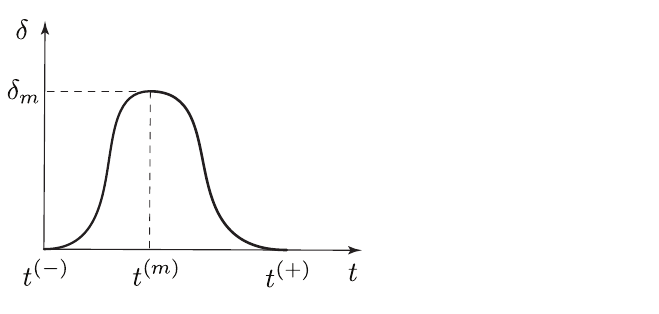
Figure 5. Indentation δ versus time for a Hertz-type contact force model [35]. Lankarani and Nikravesh start by writing the equations